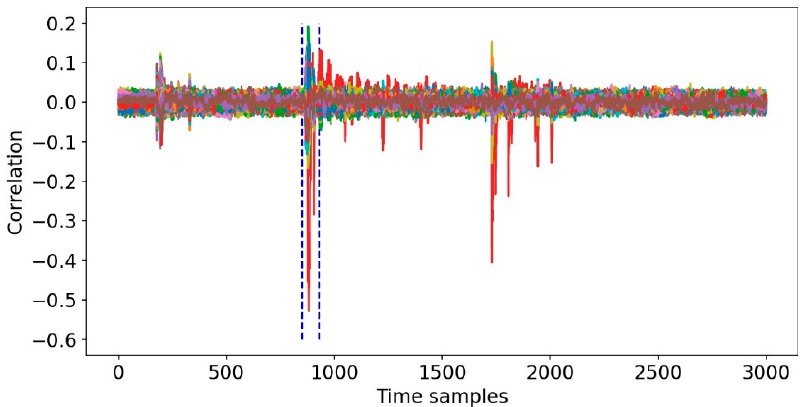
Figure 9. Correlation curves for all possible keys.